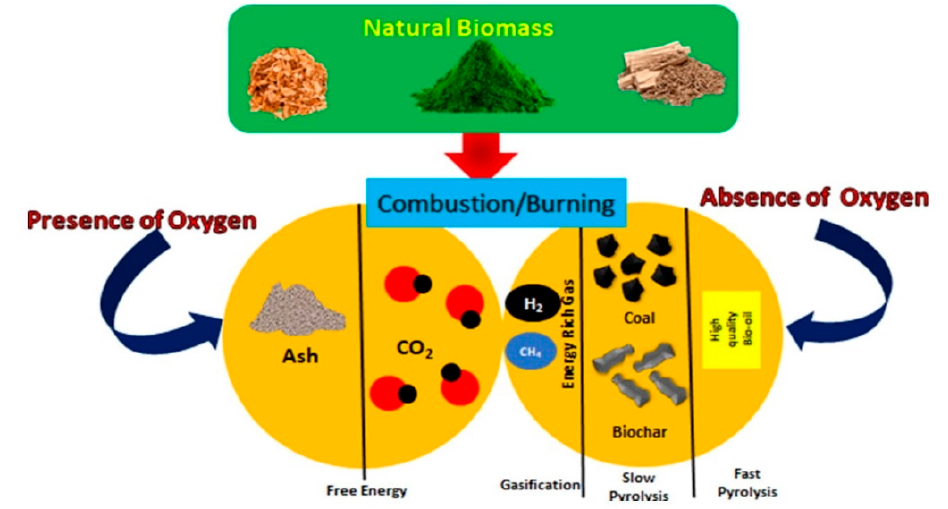
Figure 2. The pyrolysis of various biomass resources, in the presence and absence of oxygen, produces biochar and bio-oil [36].